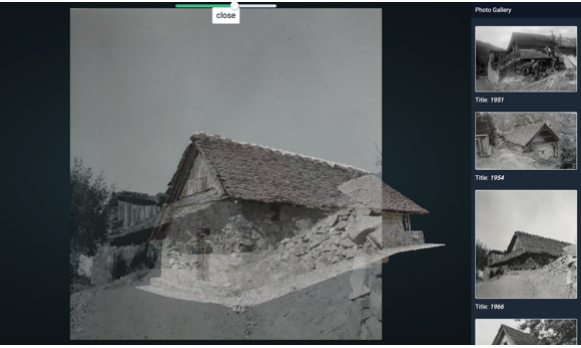
Figure 15. Panagia tou Moutoulla, Moutoullas, image gallery.